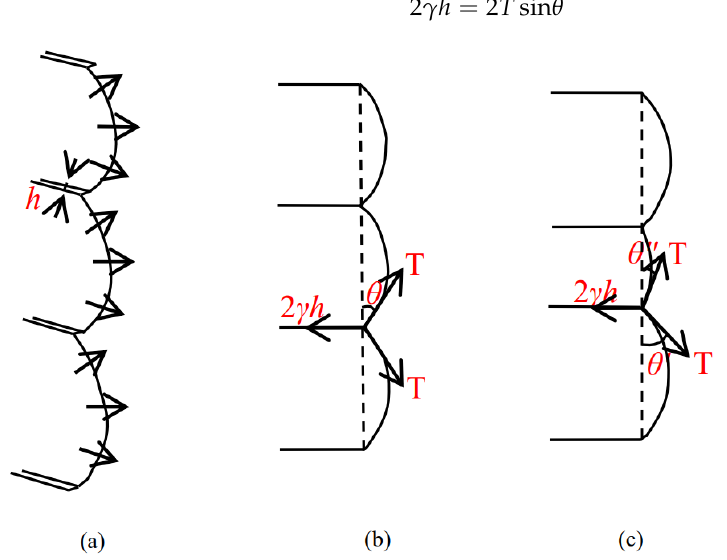
Figure 12. The diagramming of step cracks and the causes of confluence. ( a ) Step crack morphology; ( b ) Force of uniform step; ( c ) Causes of confluence.